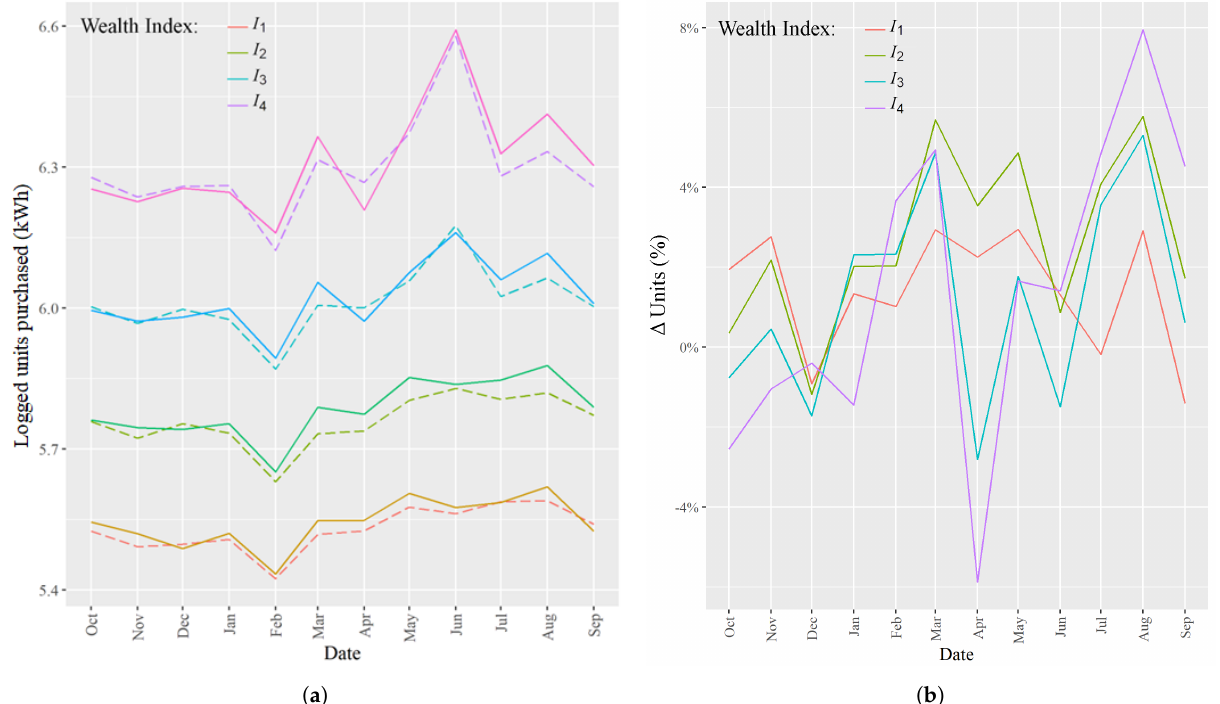
Figure 2. Plots of ( a ) the exponential average units purchased and ( b ) the percentage change in average units purchased for each wealth group per month from October 2018 to September 2019 (dashed line) and from October 2019 to September 2020 (solid